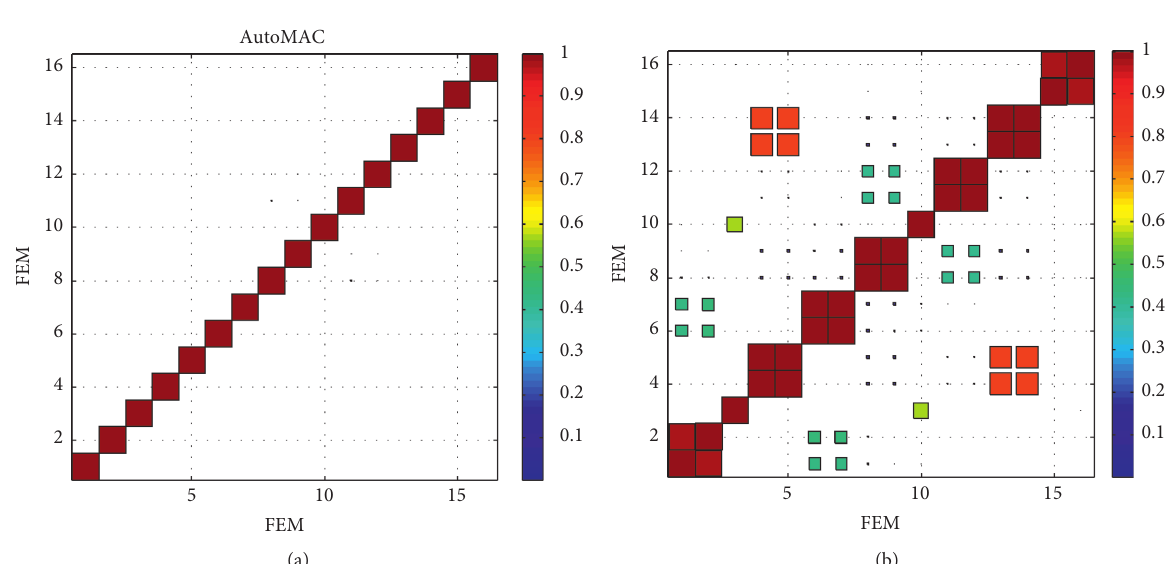
Figure 19: Autocorrelation of the FE model. (a) AutoMAC of the FE model. (b) Autocorrelation analysis by RTMs of the FE